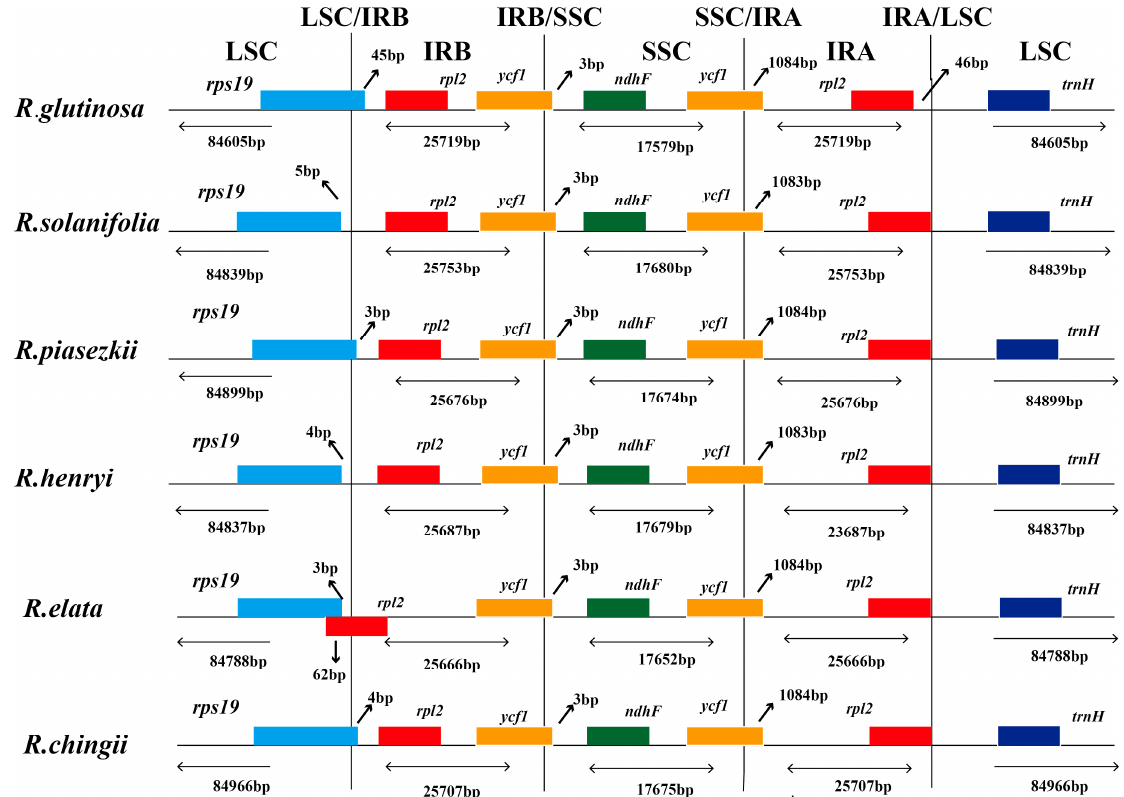
Figure 2. Comparison of the borders of large single-copy (LSC), small single-copy (SSC), and inverted repeat (IR) regions among the chloroplast genomes of six Rehmannia species. The location of two parts of inverted repeat region (IRA and IRB) was referred to Figure 1.